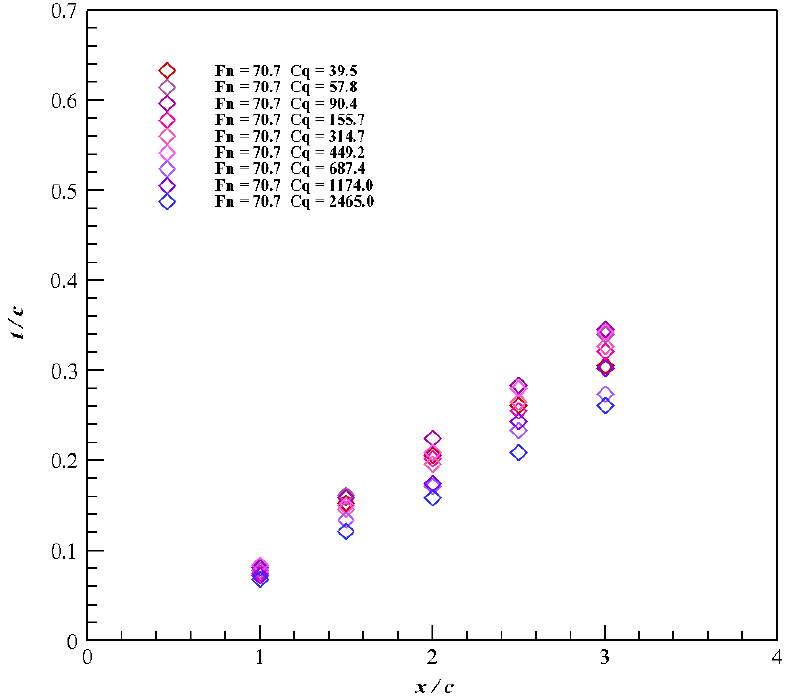
Figure 19. The non-dimensional jet thickness, t / c , variation along the non-dimensional stream-wise distance, x / c , for various non-dimensional air injection rates, C q , at Reynolds number, Re air =